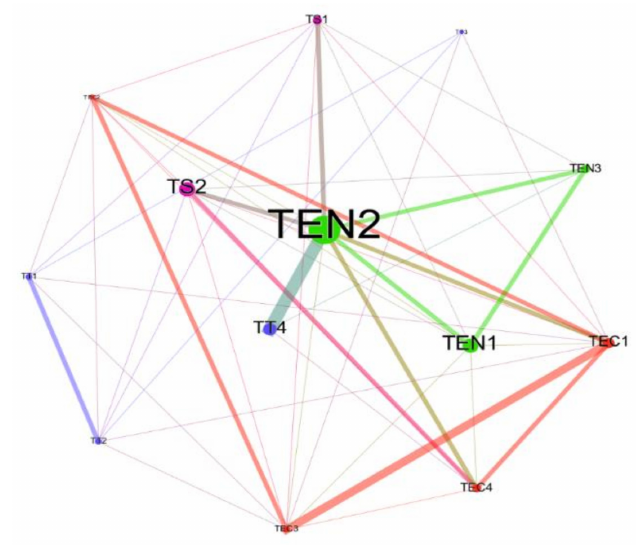
Figure 8. Technology CSFs